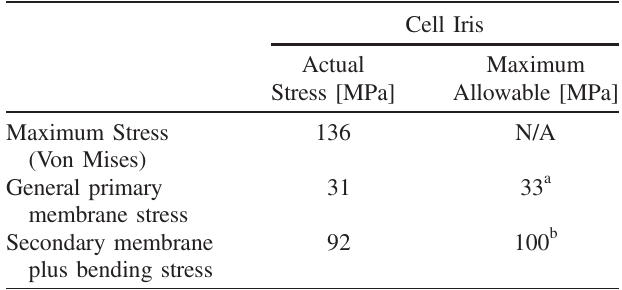
TABLE II. Cavity stress linearization and verification.